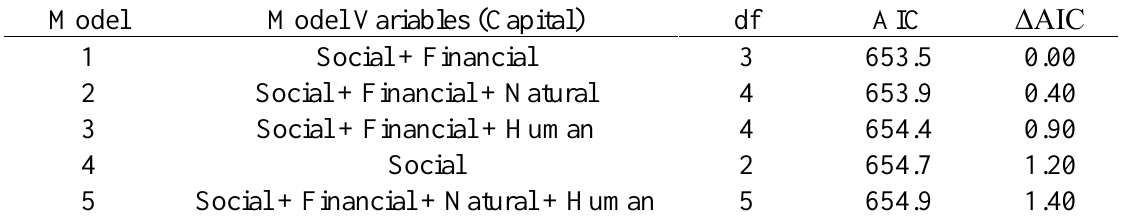
Table A2.1 Akaike information Criteria (AIC), change in AIC (ΔAIC) and degrees of freedom (df) from the top competing regression models of household adaptation attempts as a function of types of household capital.